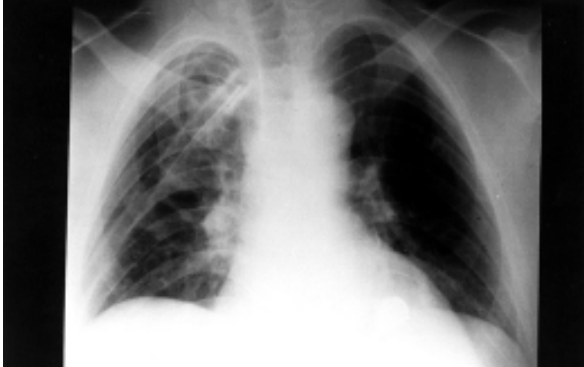
Fig. 1 - Radiografia de tórax em PA, mostrando dreno tubular no espaço pleural direito e projétil situado na silhueta cardiovascular.